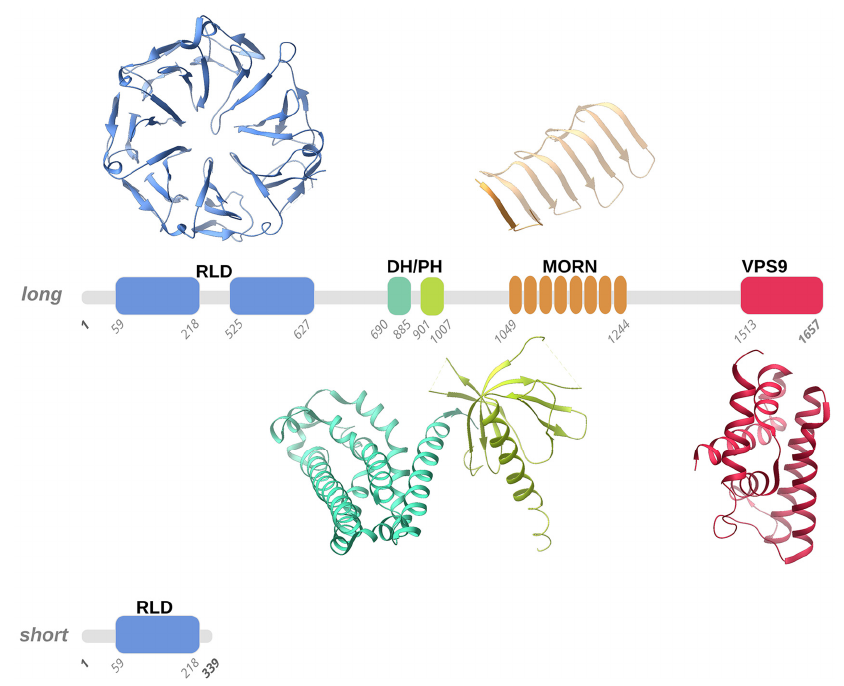
Figure 1. Schematic representation of the long and short forms of human Alsin. According to homology modelling, four structured domains, numbered according to the Uniprot Q96Q42 entry, were predicted in human Alsin, namely the RLD (RCC1-like domain), DH-PH (Dbl homology- pleckstrin homology), MORN (membrane occupation and recognition nexus), and VPS9 (vacuolar protein-sorting 9) domains. We used representative structures of these domains (PDB entries 1A12, 2Z0Q, 6T4D, and 2OT3) to illustrate the 3D folds that the RLD, DH-PH, MORN, and VPS9 domains predicted in human Alsin, respectively, may adopt. Structured domains are shown as ribbons with the same color code as the one utilized for the sequence schematic